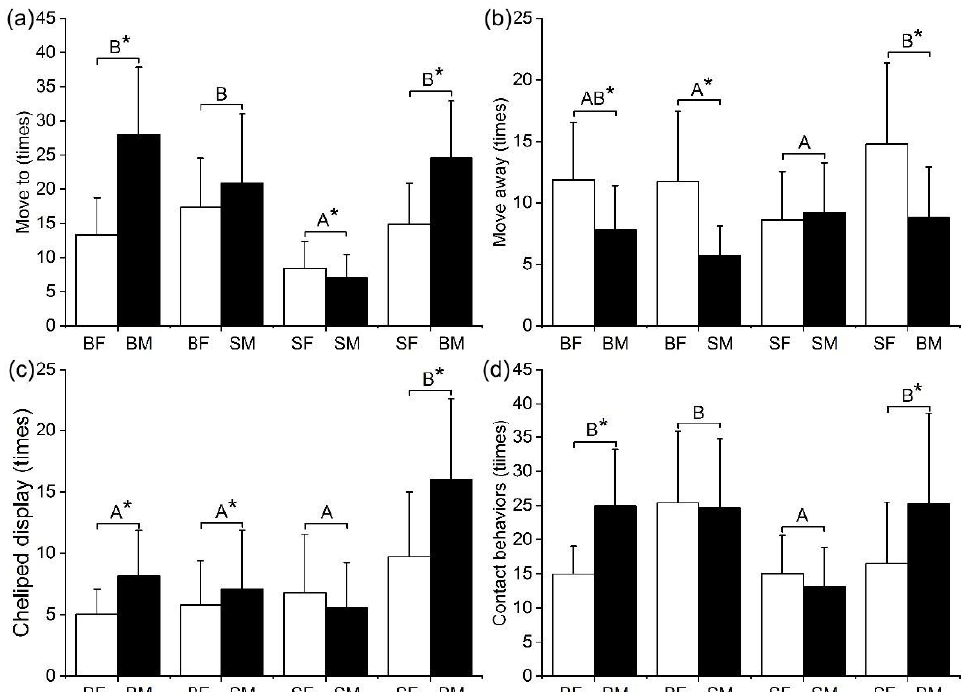
Figure 4. Frequency of agonistic behavior among different groups: move to ( a ); move away ( b ); cheliped display ( c ); and contact behaviors ( d ) of crabs in the fight. Note: Capital letters represent significant difference of agonistic behavior among different groups; an asterisk (*) denotes significant difference of behaviors between two matched crabs. ( p < 0.05). Table 4. Results of two-way ANOVAs to determine the effects of boldness and sex on the concentra- tions of glycogen in claw, glucose in the hemolymph, and OCR of swimming crabs P. tritubercuatus . Glycogen in Claw Glucose in Hemolymph Source